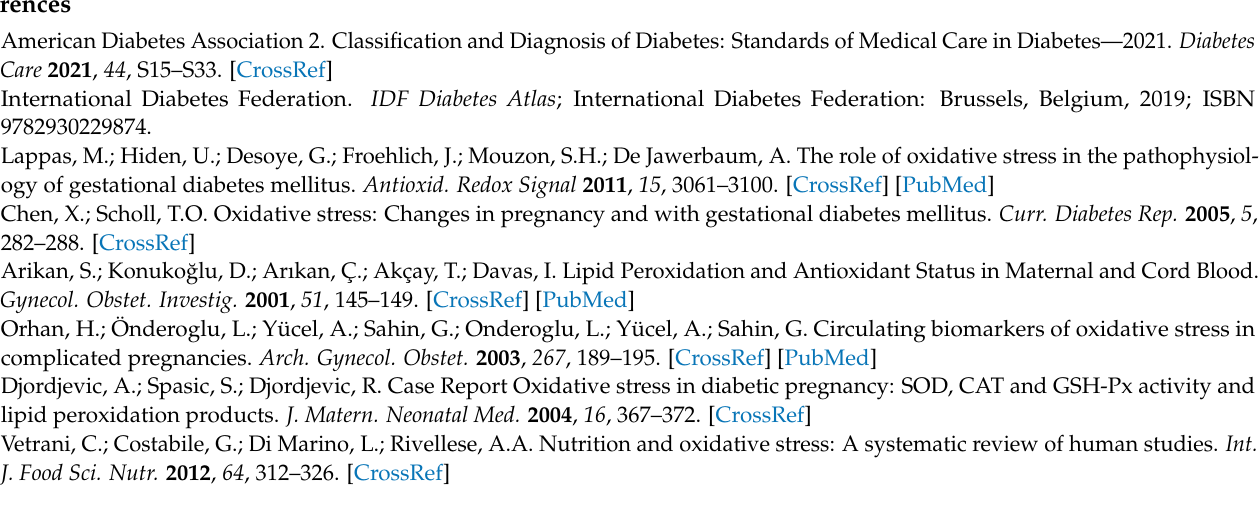
Table S1: Excluded studies, Table S2: SUCRA values of different antibiotic treatments for the primary and secondary outcomes, Table S3: GRADE for the ∆ TAC outcome, Table S4: GRADE for the ∆ MDA